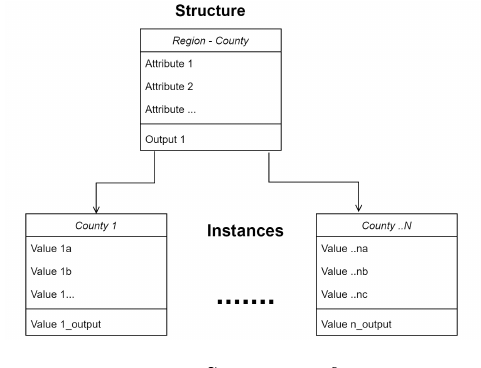
Figure 1: Structure of data